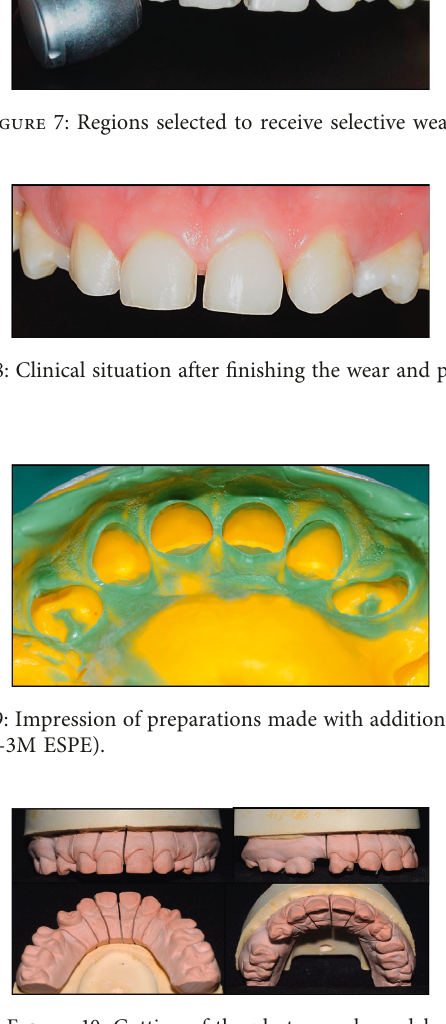
Figure 10: Cutting of the plaster work model.